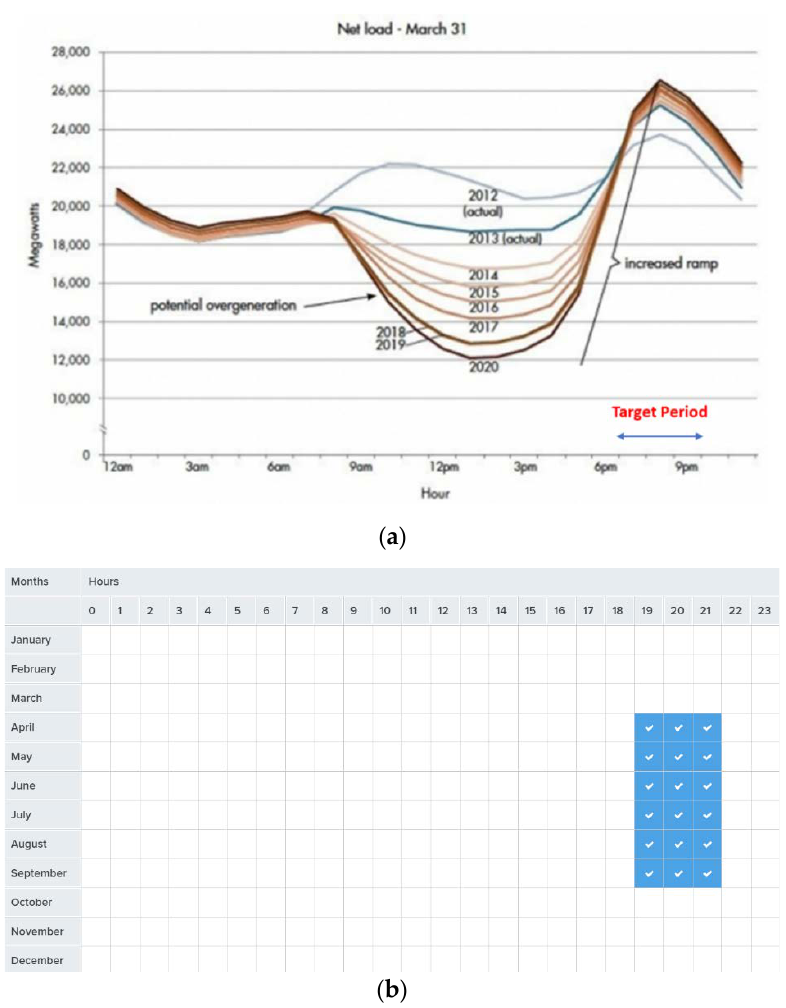
Figure 6. ( a ) “Duck Curve” in CAISO and ( b ) Target Period window selected for analyzing the ability